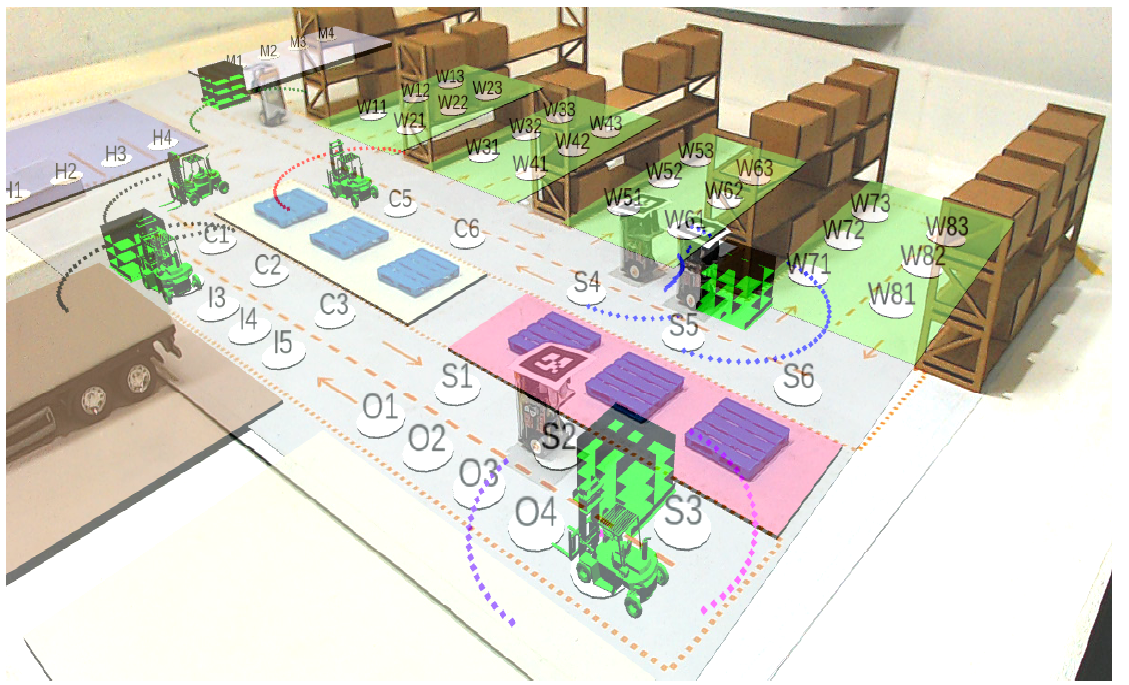
Figure 12. ARENA in perspective with AR.